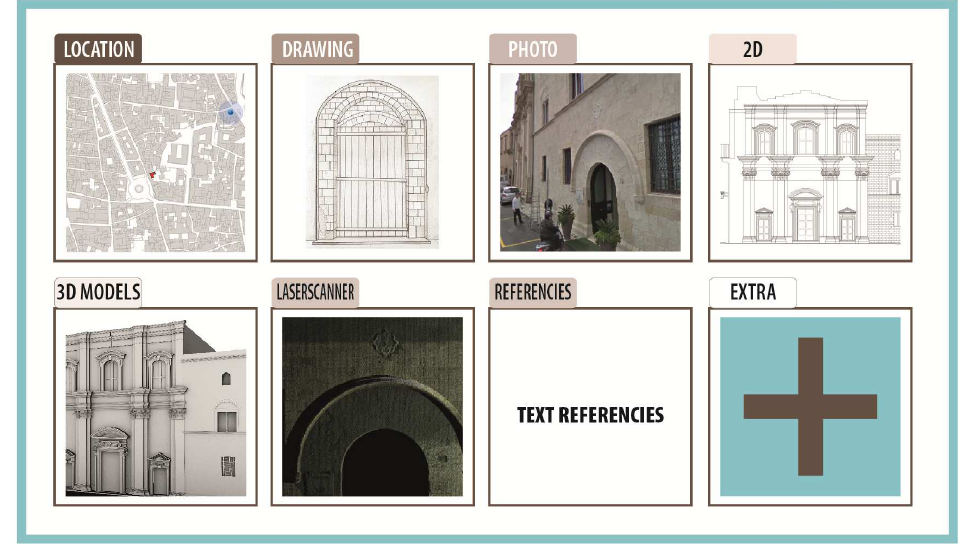
Figure 7. Crabnebula software. Elements of the information technology